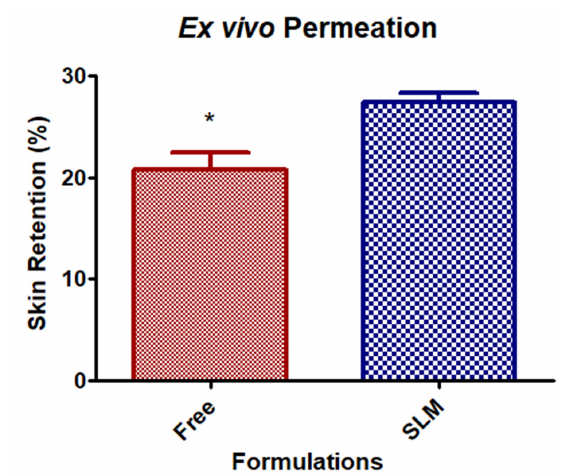
Figure 5. Amount of DEET retained in the skin after ex vivo permeation studies: black bar shows the result of cutaneous retention of free repellent and white bar shows the result of the retention of microencapsulated DEET in SLM. Results are Mean Standard deviation of n = 5 determinations. * Mean value is significantly different with p <